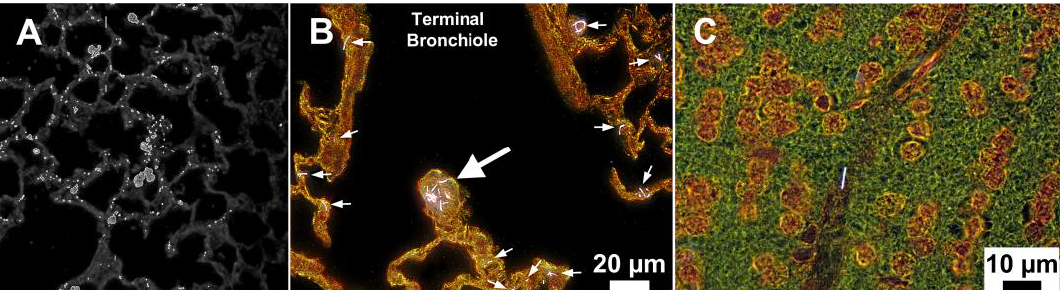
Figure 4. ( A ) Dark-field image (400 × ) using Particle Fitting Function to locate maximally carboxylated MWCNT in lung tissue of a BALB/c mouse following three-day particle exposure. Bright grey areas designate regions with nanotubes. ( B ) Enhanced dark-field image of the transition region between a terminal bronchiole and first alveolar duct bifurcation of C57BL/6J mouse at 168 days after exposure to MWCNT. The large arrow indicates a cluster of MWCNTs (white fibres) in the ridge of the first alveolar duct bifurcation. Smaller arrows indicate some of the numerous singlets and small MWCNT structures distributed throughout the alveolar septa of this critical transition region between conducting airways and gas exchange regions of the lungs. ( C ) Enhanced dark-field image of MWCNT fibres in the brain of C57BL/6J mouse at 336 days after inhalation exposure. MWCNT fibre is bright white, cell nuclei are brownish red, and other tissue elements are green. Figure 4A adapted from Ref. [89] under the terms of the Creative Commons Attribution License (CC-BY 4.0), scale not specified. Figure 4B adapted from Ref. [94] under the terms of the Creative Commons Attribution License (CC-BY 2.0). Figure 4C adapted from Ref. [96] under the terms of the Creative Commons Attribution License (CC-BY